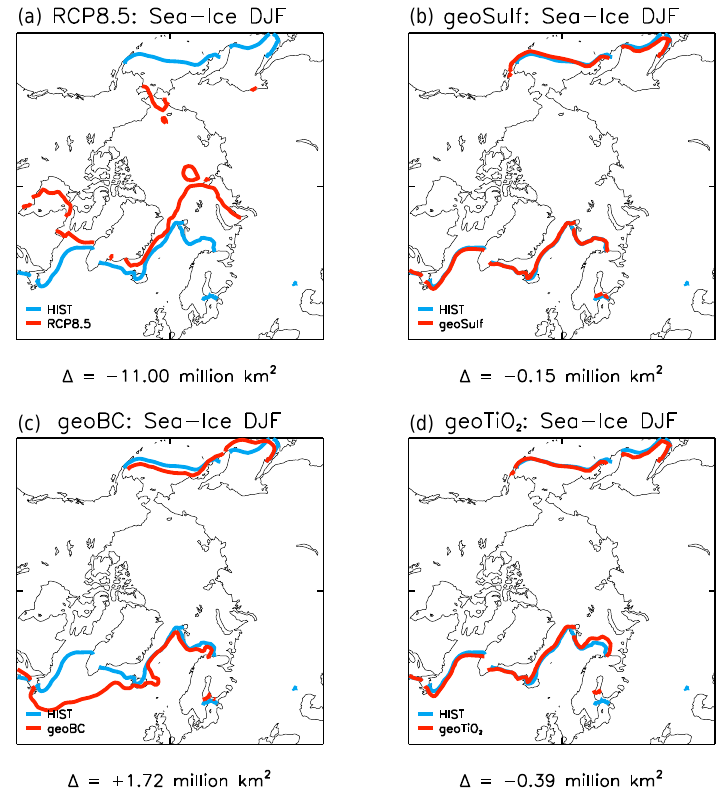
Figure 9. DJF Northern Hemisphere sea-ice edge plotted with the HIST